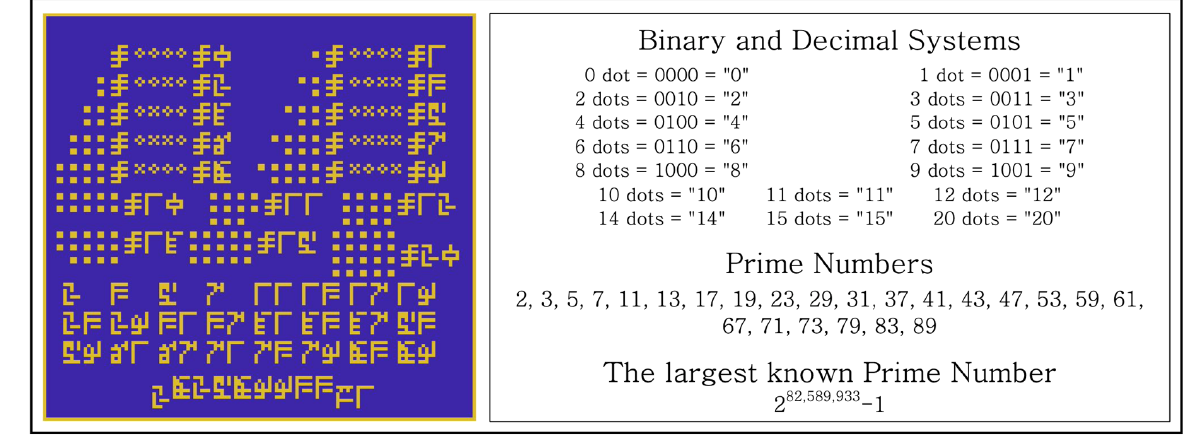
Figure 7. Pictural representation and explanation of the BITG message, page 1.